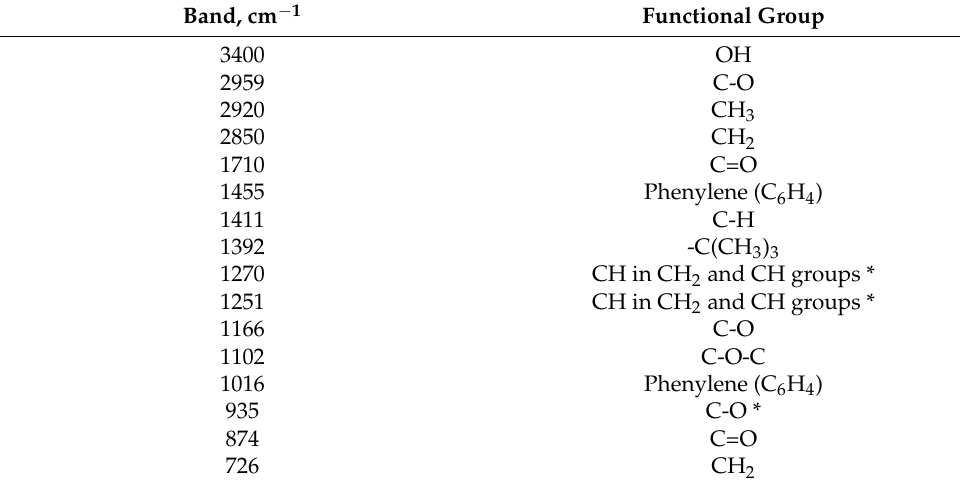
Figure 9. IR spectra of the PLA/PBAT composite samples in the 4000–600 cm − 1 range (blue: before composting; red: after 180 days of composting; green: after 365 days of composting). Table 4. IR spectral bands. Band, cm − 1 Functional